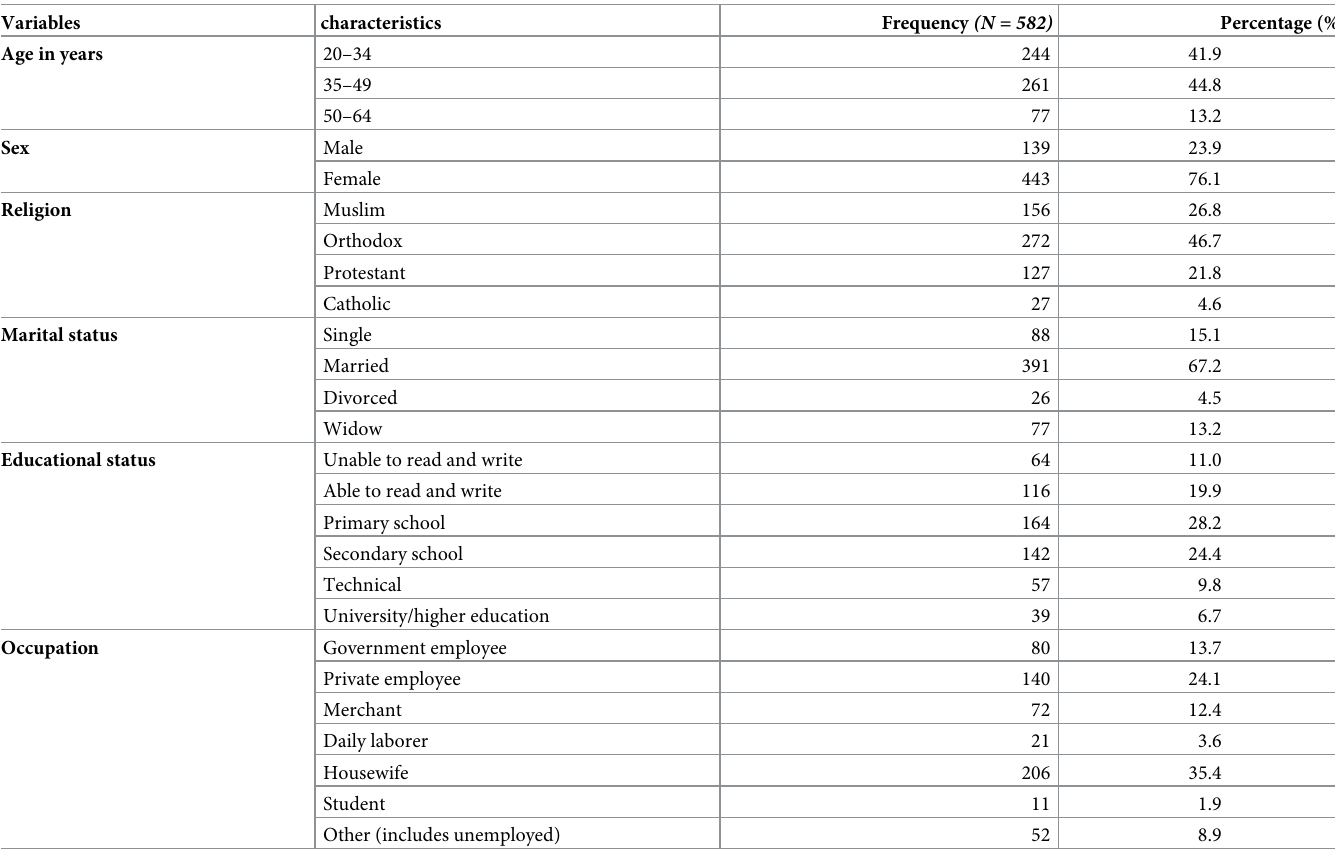
Table 1. Socio-demographic characteristics of study participants in Addis Ketema sub-city, Addis Ababa, Ethiopia, 2020.